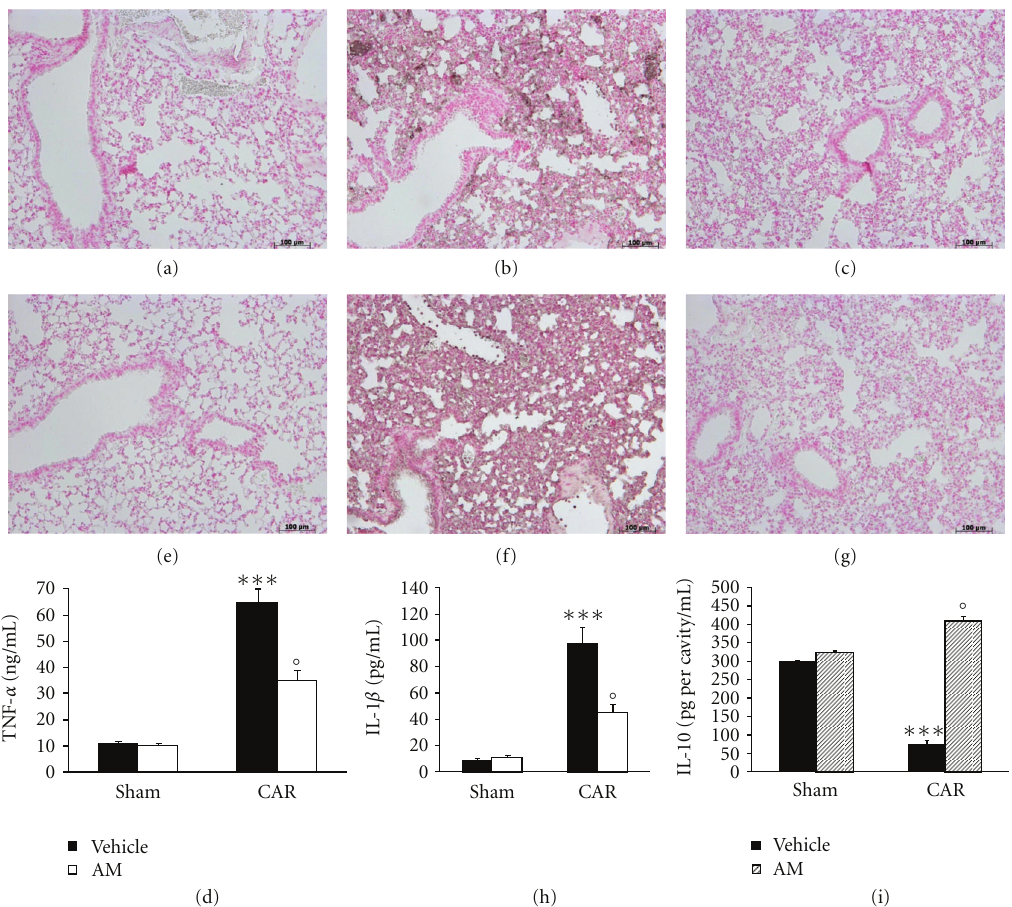
Figure 5: E ff ect of adrenomedullin (AM) on proinflammatory cytokine expression and release. Lung sections taken from CAR-treated mice showed positive staining for TNF- α and IL-1 β (b and f, resp.). There was a marked reduction in the immunostaining for TNF- α and IL-1 β in the lungs from CAR-treated mice treated with AM (c and g, resp.). No staining for either TNF- α (a) or IL-1 β (e) in lung tissues obtained from the sham group was detected. The figure is representative of at least 3 experiments performed on di ff erent experimental days. Moreover, pleural injection of CAR caused an increase in exudate levels of TNF- α (d) and IL-1 β (h). AM significantly reduced TNF- α and Il-1b levels (d and h, resp.). Finally IL-10 were measured in the lung exudates. In CAR-treated mice, however, significant decreases ( P < 0 . 01) in the levels of IL-10, in comparison to values obtained inAM-treated mice, were detected (i). Data are means ± s.e.m. of 10 mice for each group. ∗ P < 0 . 01 versus sham group. ◦ P < 0 . 01 versus